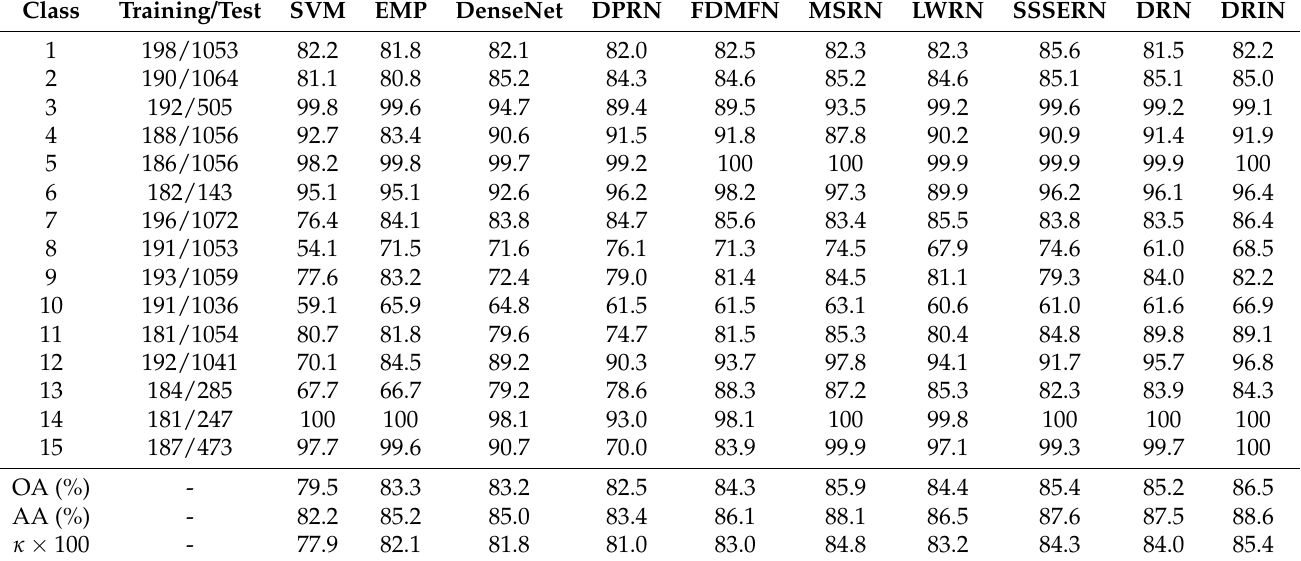
Table 10. Classification results for the UH dataset.